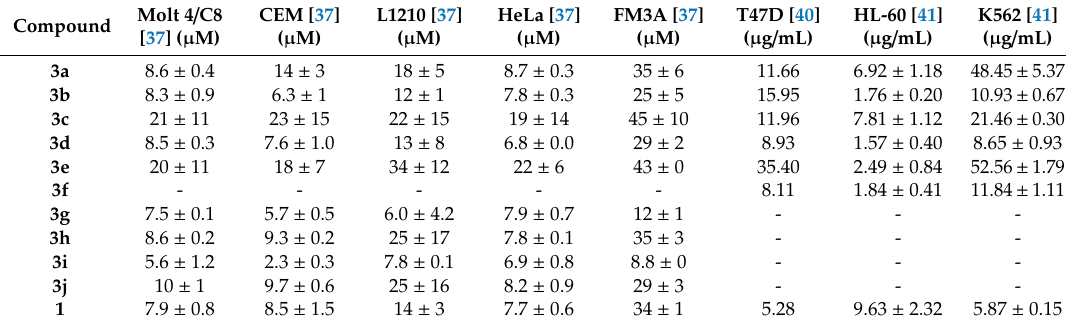
Table 4. IC 50 values of methoxy-aminochalcones ( 3a – j ) against murine leukemia (L1210),